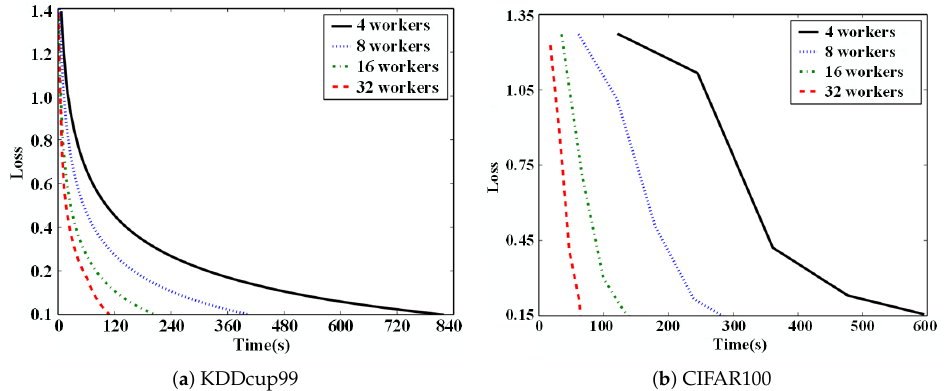
Figure 5. Acceleration effect with different working